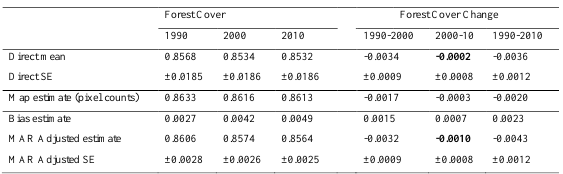
Table 2: Estimates Forest cover/change proportion forest from segments, figures in bold indicates estimates not significantly different from 0 (Source: Sannier et al., 2014).